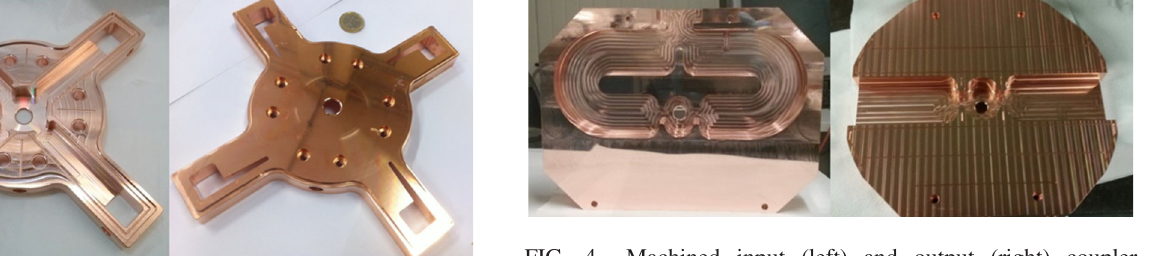
FIG. 4. Machined input (left) and output (right) coupler components.